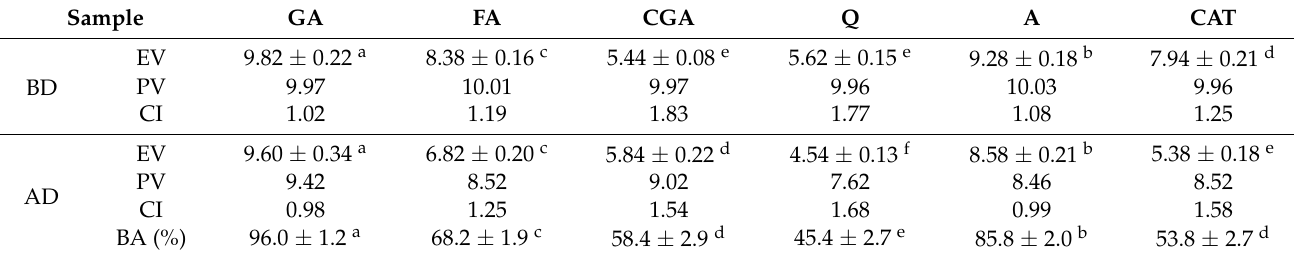
Table 1. Effect of food matrix on phenolic content and in vitro